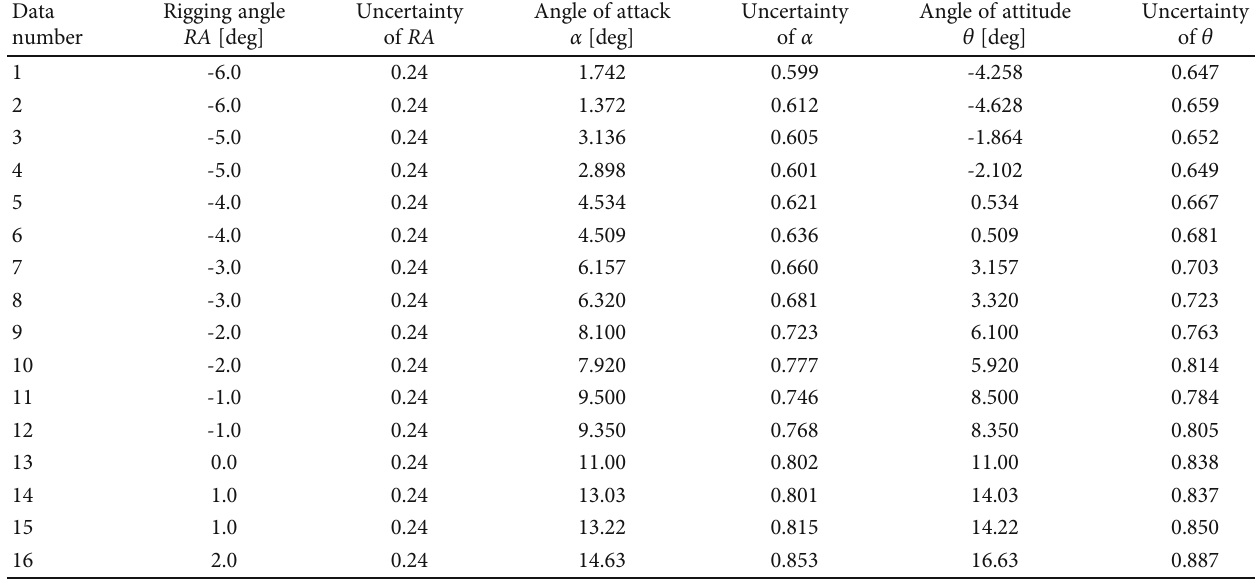
Table 9: Wind tunnel test result of 100Pa wind condition.